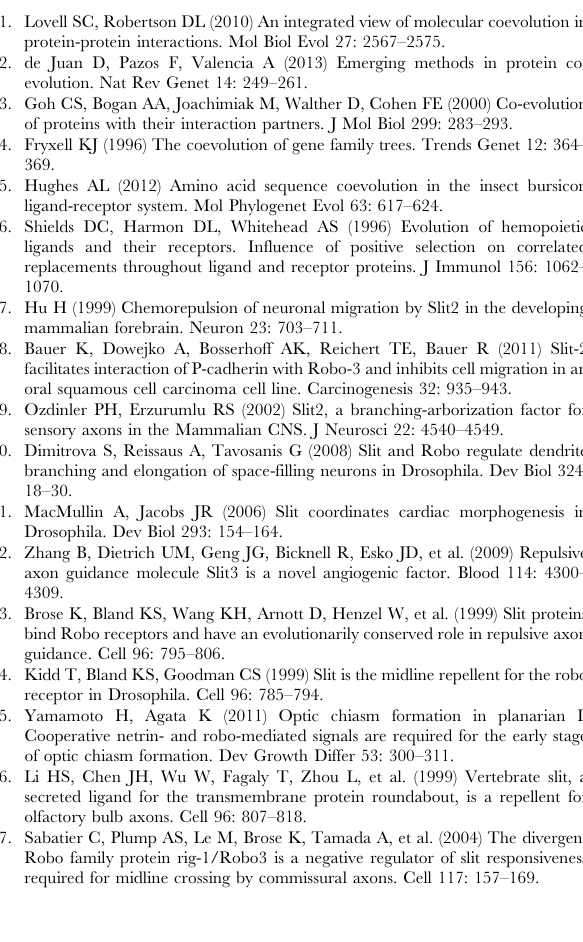
Table S2 The accession numbers of sequences used in correlated evolution rate analysis. (XLS) Table S3 The accession numbers of insect sequences used in PAML selection analysis. (XLS) Table S4 The accession numbers of vertebrate sequenc- es used in PAML selection analysis. (XLS) Table S5 Analysis of changes in the interacting sites between Slit and Robo. (XLS)